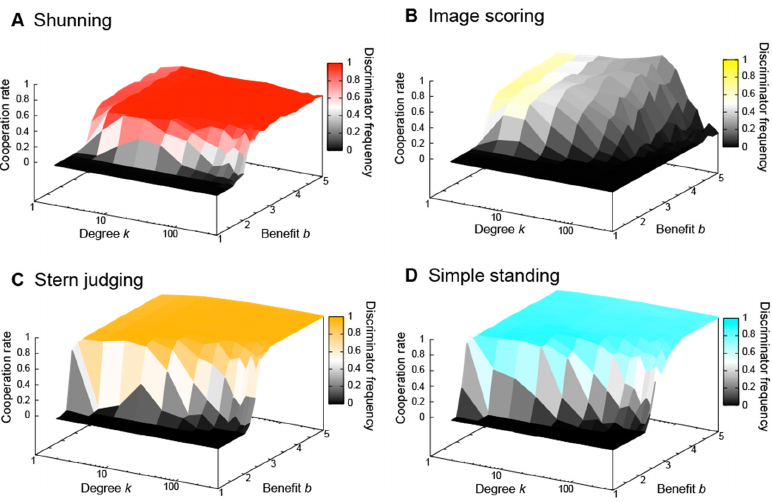
Figure 2. Cooperation rates and Discriminator frequencies in indirect observation and public assessment